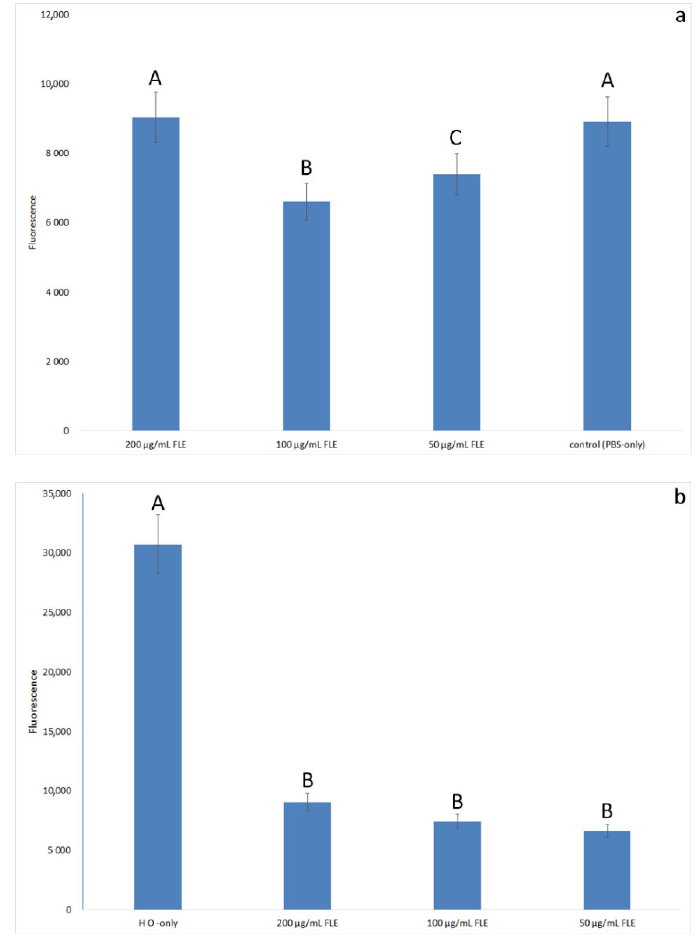
Figure 3. ROS expression (fluorescence) of HFFF ‐ 2 cells: ( a ) treated with 50–200 μ g/mL Faxonius limosus extract (FLE) or PBS (control); ( b ) treated with 50–200 μ g/mL Faxonius limosus extract (FLE) or PBS (control) and 500 μ M hydrogen peroxide. Different letters mean that the values for the bars differ statistically ( p < 0.05).